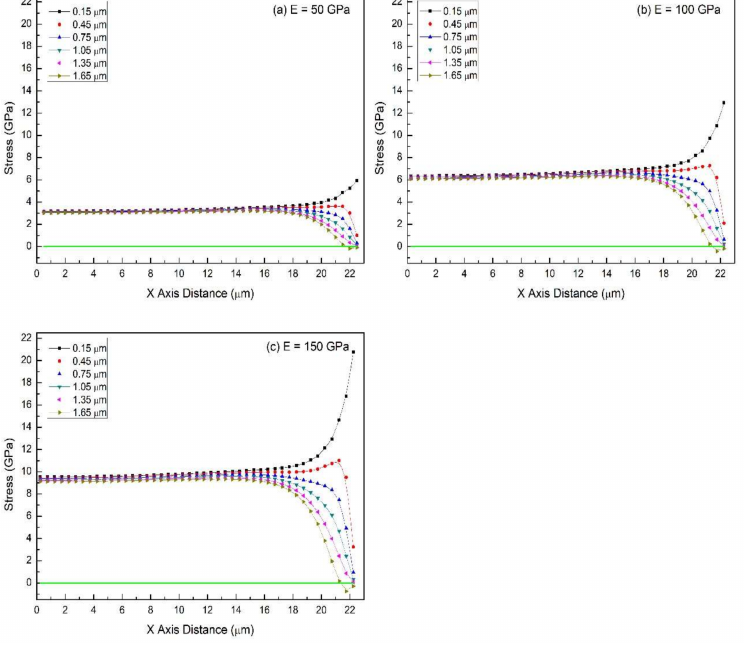
Figure 6. The in-plane stress distribution (dot-line plot) in films of different Young’s modulus for the case of the film/substrate system being tested in tension: ( a ) E = 50 GPa, ( b ) E = 100 GPa, ( c ) E = 150 GPa.